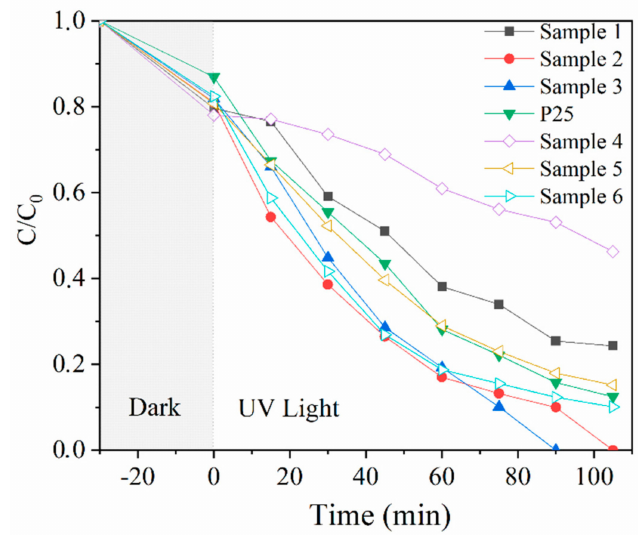
Figure 2. Photocatalytic degradation of RhB under UV light by P25 and TiO 2 @SiO 2